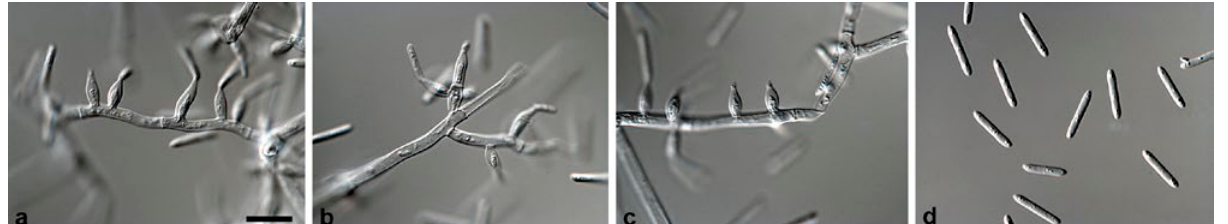
Figure 2. Cylindrodendrum hubeiense (CBS 129.97). a–c. Conidiophores on somatic hyphae. d. Conidia. Scale bar: a = 10 μm (apply to